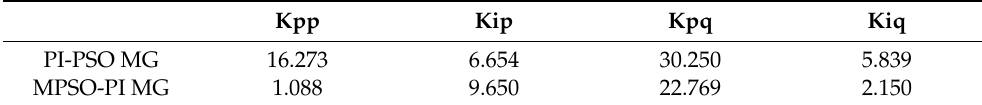
Table 3. Obtained optimized P.I. parameters.